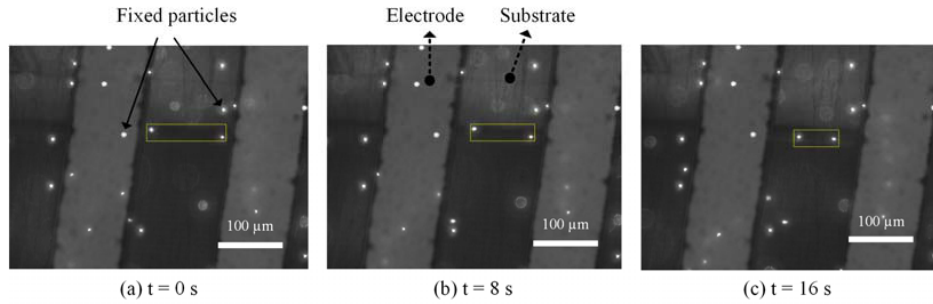
Figure 5. Image series showing particle movement in 0.5× SSC at 10 kHz.